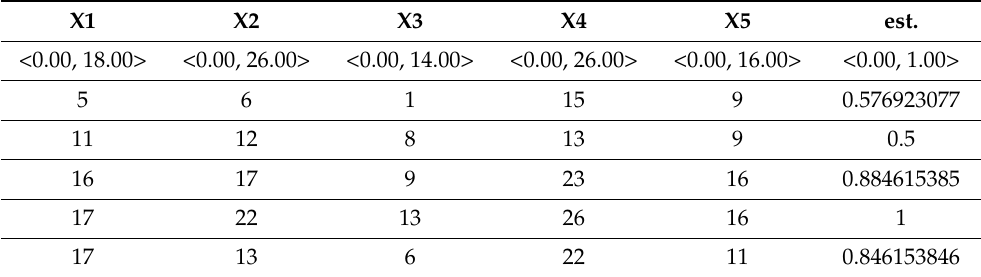
Table 5. Data observations and